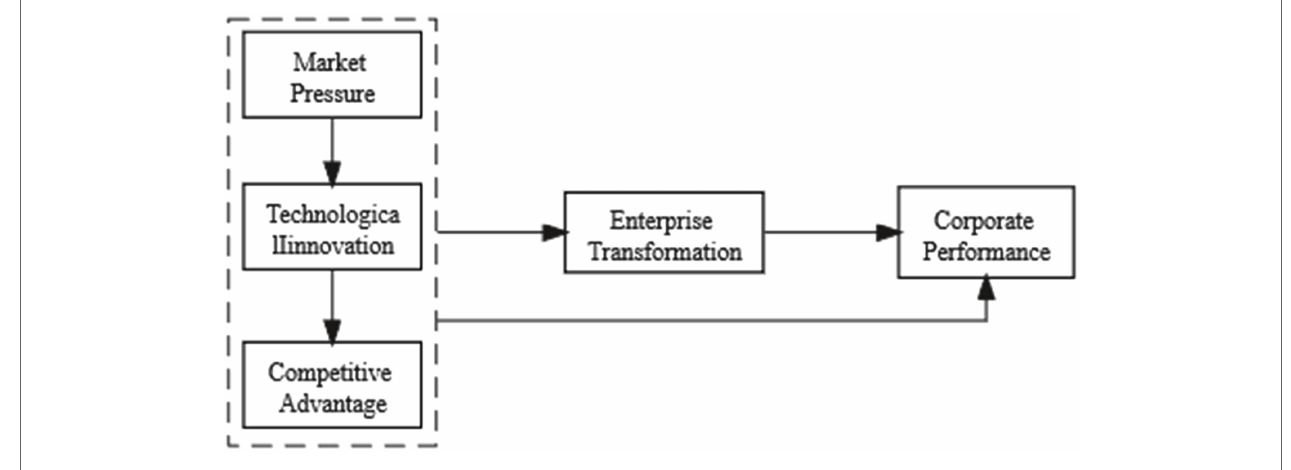
FIGURE 1 | Theoretical